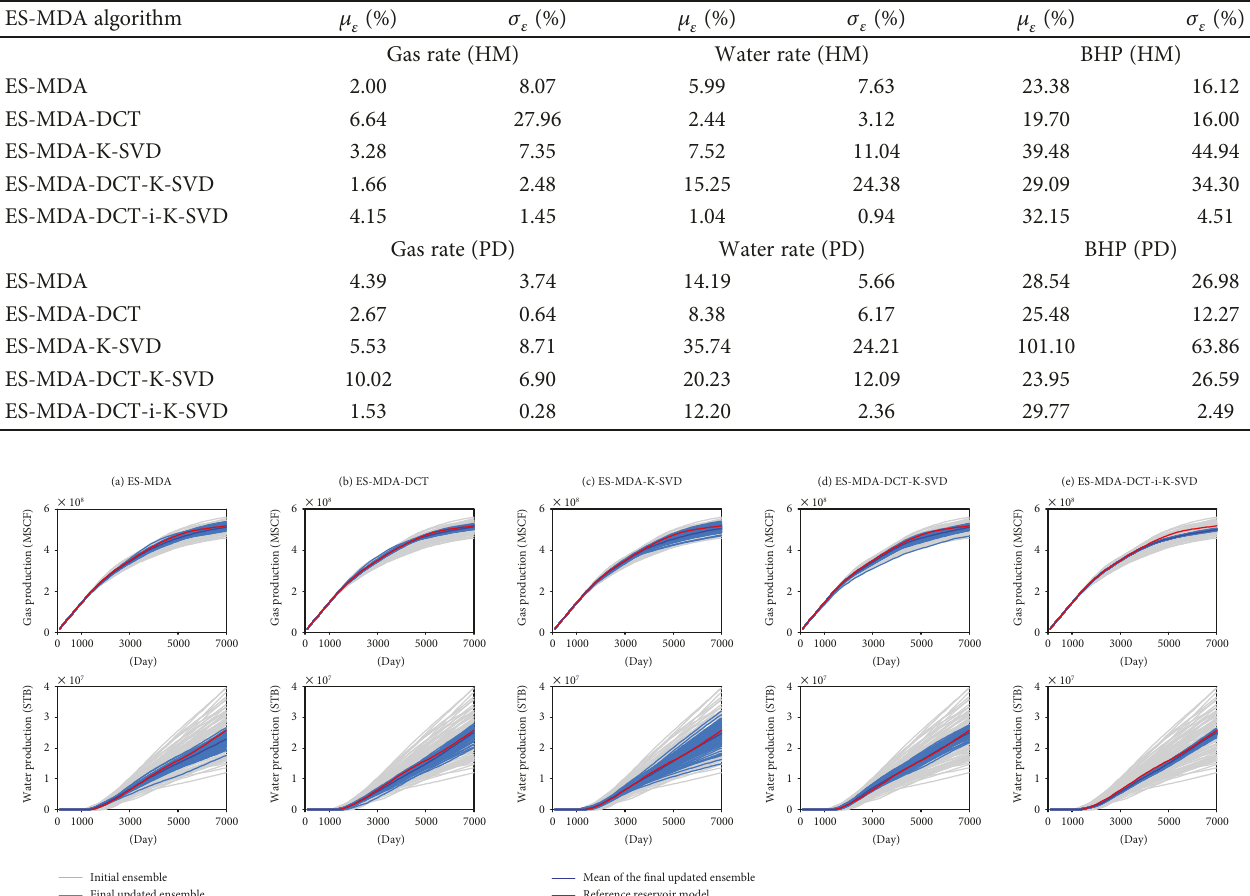
Table 7: Statistical parameters of history matching (HM) and prediction (PD) errors in terms of gas rate, water rate, and BHP (Case 2). μ σ ε refer to mean and standard deviation of the ensemble error, respectively.